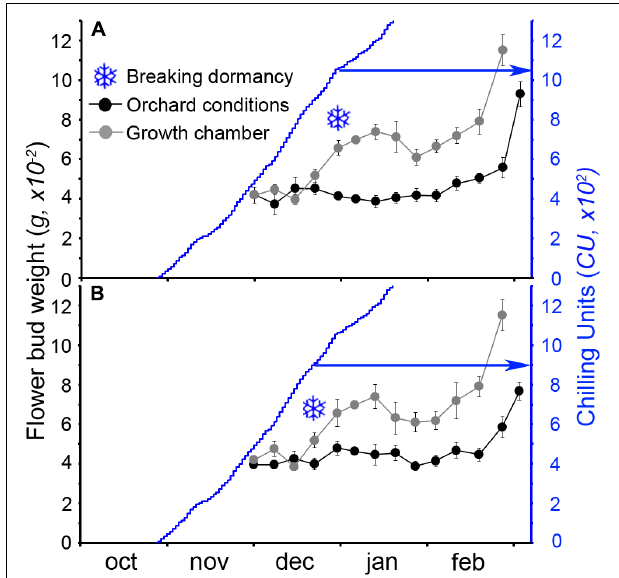
FIGURE 4 | Estimation of breaking of endodormancy in two sweet cherry cultivars. Flower bud weight in orchard conditions and after a week in the growth chamber. Snowflakes: increment of at least 30%, when chilling was considered fulfilled. (A) Cultivar “Bing.” (B) Cultivar “Burlat” (n =